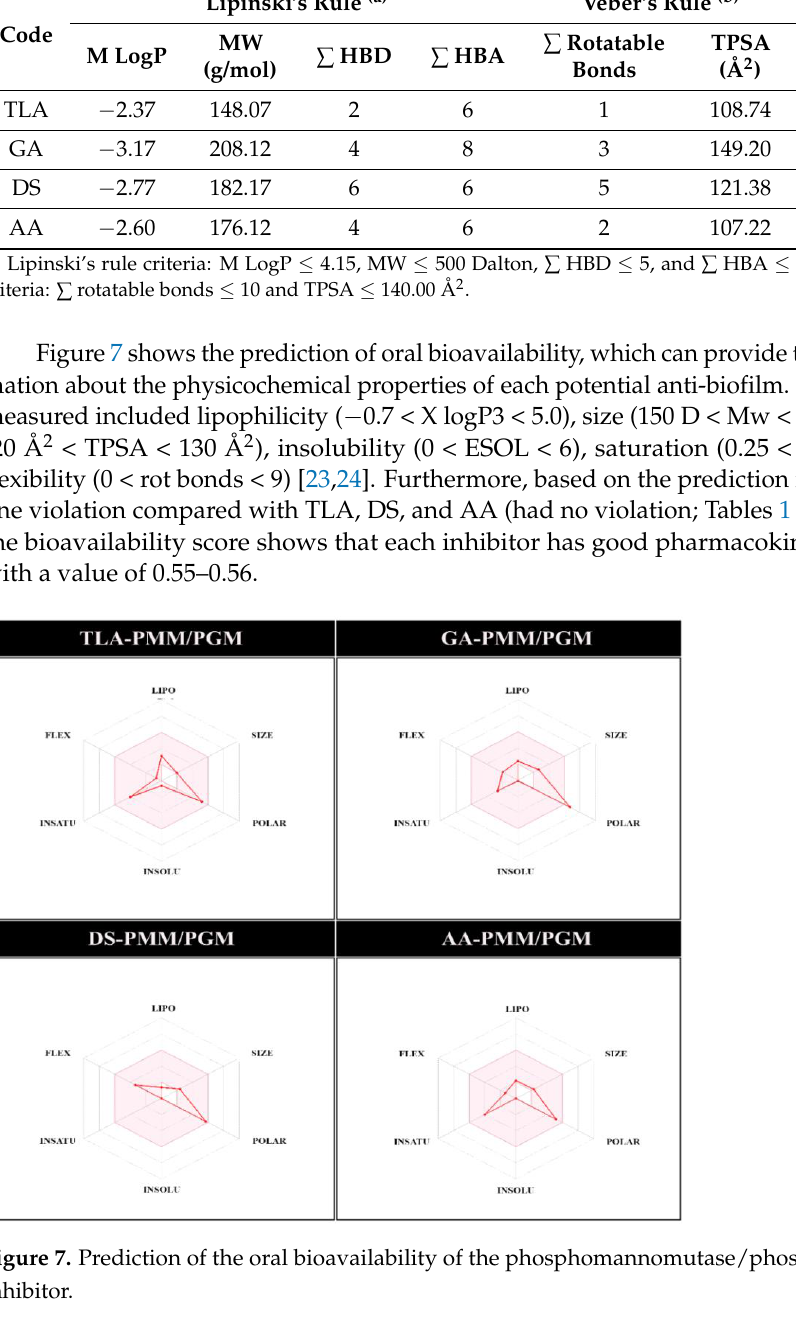
Table 1. Drug-likeness analysis based on Lipinski’s rule and Veber’s rule. Table 1. Drug- likeness analysis based on Lipinski’s rule and Veber’s rule.